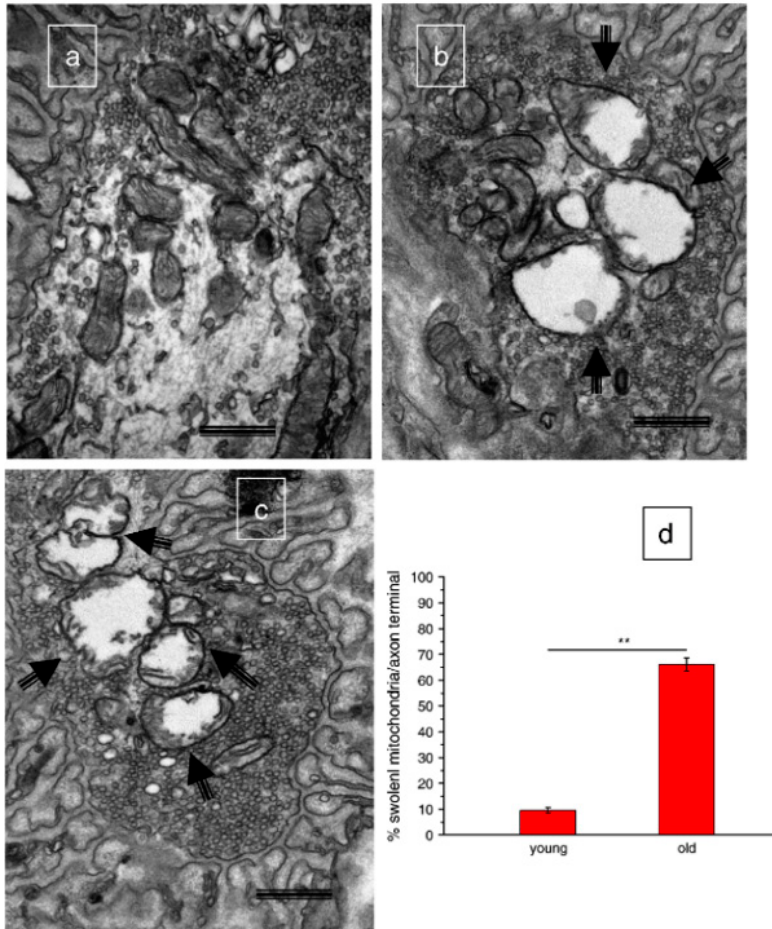
Figure 3. Compared to young animals ( panel a ) mitochondria in the motoneuron terminals of aged rats exhibit swelling, distorted cristae and membrane rupture (arrows in panels b – c ); features that are consistent with having undergone mitochondrial permeability transition. ( panel d ) provides the percentage of swollen mitochondria in aged versus young rats. Bar = 500 nm. ** p < 0.001. Figure reproduced with permission from [47].